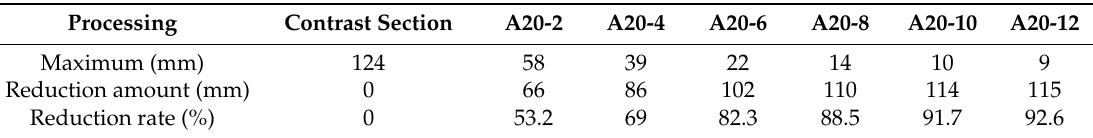
Table 3. Eigenvalue and reduction rates of the frost heave amounts of EPS insulation boards with different thicknesses.